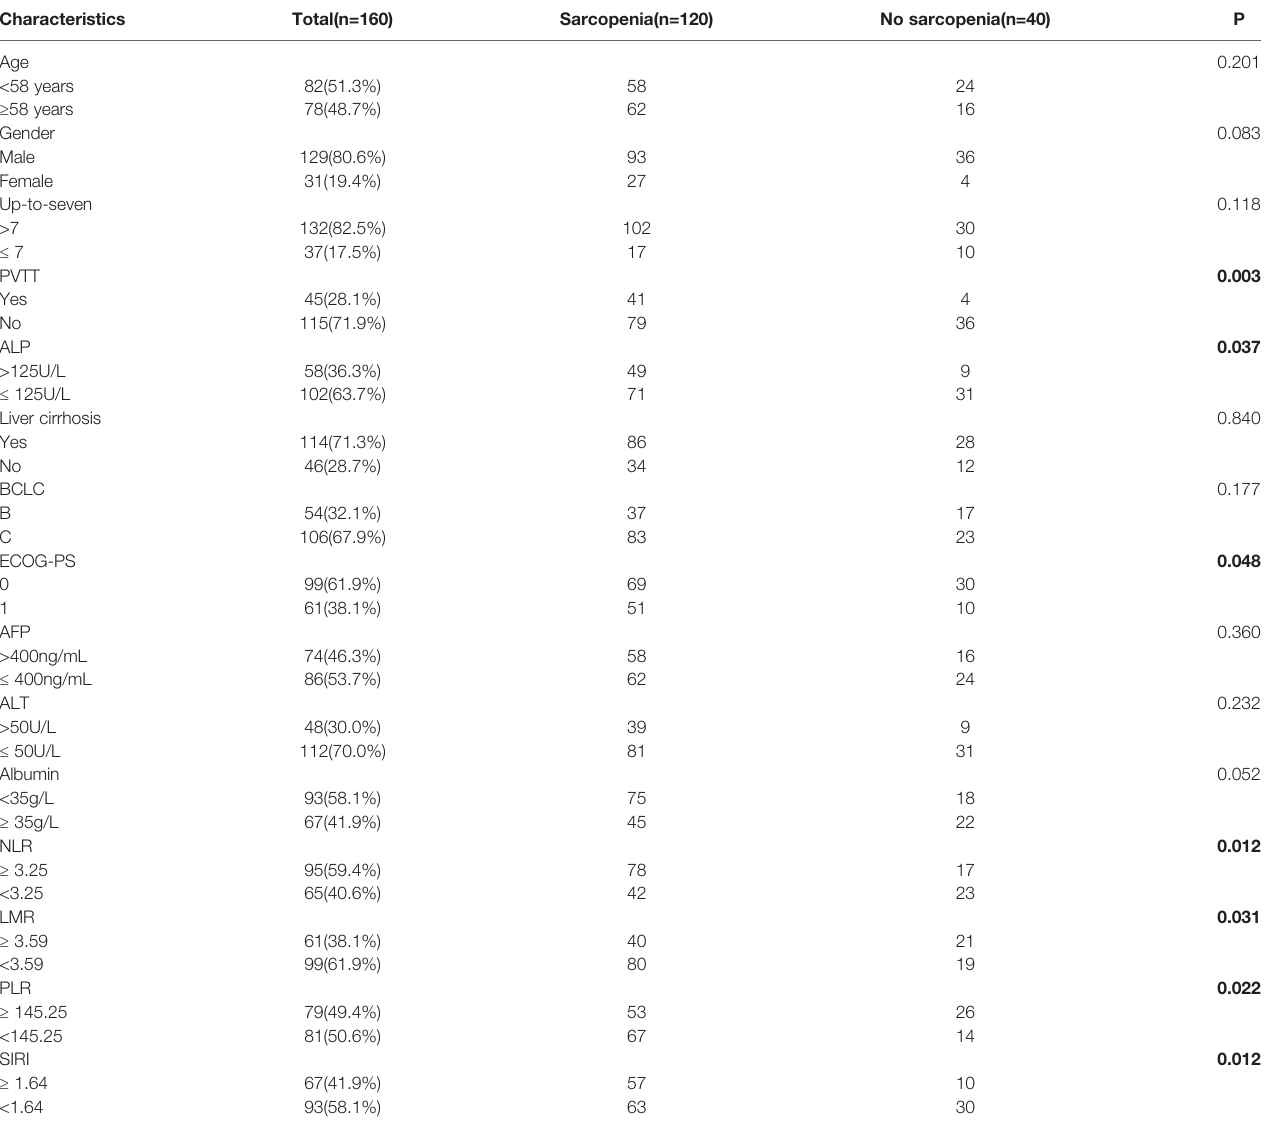
TABLE 1 | Baseline characteristics of patients strati fi ed by sarcopenia.